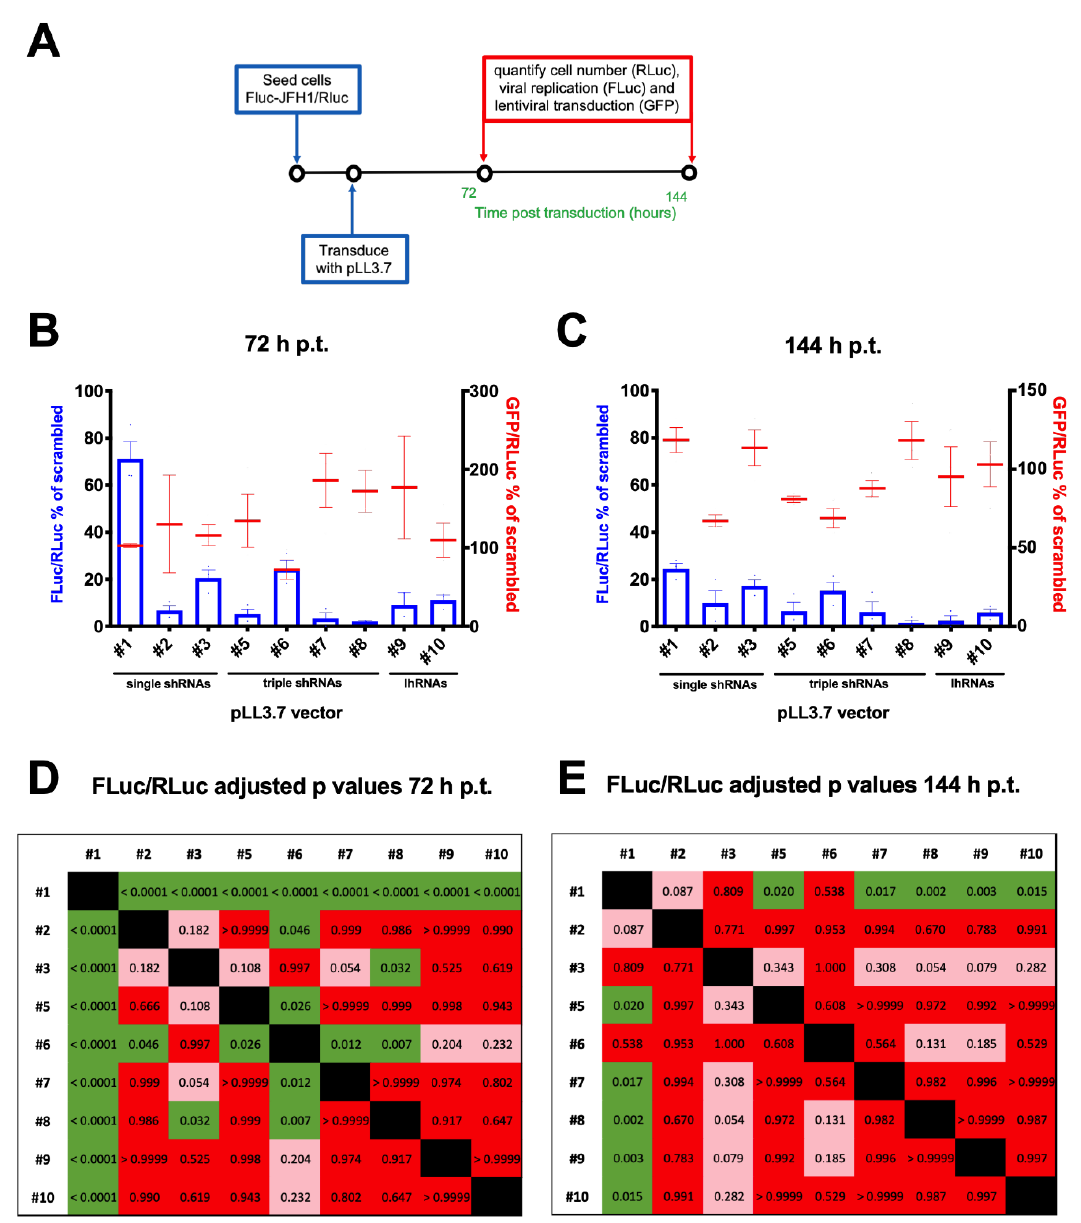
Figure 6. Inhibition of HCV replication as mediated by the combination of miRNA-expressing pLL3.7 vectors. ( A ) 2 × 10 4 cells/cm 2 and 1 × 10 4 cells/cm 2 of FLuc-JFH1/RLuc cells were seeded in 24-well plates, and after 24 h were transduced with different lentiviral vectors encoding for a combination of shRNAs/lhRNAs targeting the sequences described in Material and Methods for 72 and 144 h p.t., respectively. At the indicated time points p.t., cells were lysed and processed for fluorimetric detection of transduction efficiency (GFP) and luminometric detection of cell number (RLuc) and HCV replication (FLuc). The FLuc/RLuc (blue columns) and GFP/RLuc (red bars) ratios relative to cells transduced with the indicated pLL3.7 shRNA/lhRNA lentiviruses at 72 ( B ) and 144 ( C ) hours p.t., are expressed as a percentage of the mean values obtained for cells transduced with pLL3.7 encoding for a non-targeting shRNA (Scrambled). Data are the mean + standard error of the mean relative to three independent experiments. Adjusted p values from the Turkey multiple-comparison post-test are reported for the FLuc/RLuc ratios relative to cells transduced with each lentiviral particle at 72 ( D ) and 144 ( E ) hours p.t. Green: p value < 0.05; pink: 0.05 < p value < 0.5; red: p value > 0.5; black: no p value calculated. Lentiviral vectors were as follows: #1, pLL3.7/U6-shCypA; #2, pLL3.7/U6- shHCV321; #3, pLL3.7/U6-shPI4KIIIα; #4, pLL3.7/U6-shScrambled;#5, pLL3.7/U6-shHCV321-H1- shCyp-7SK-shHCV353;#6, pLL3.7/U6-shPI4KIIIα-7SK-shHCV321-H1-shCypA; #7,